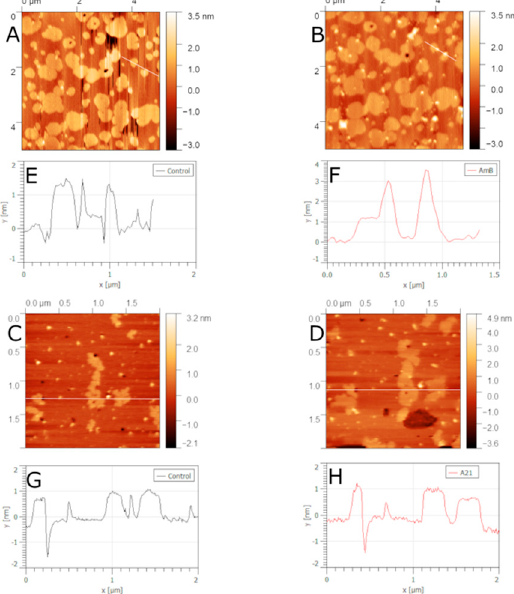
Figure 13. Topographic images of supported lipid bilayers composed of POPC:ESM 1:1 mol:mol + 20 mol% ergosterol in the presence ( B , D ) or absence of polyenes ( A – C ). Polyenes were added by increments of 0.5 µM until a clear effect was observed. For AmB ( B ), this occurred at 1 µM; for A21 at 2 µM. ( E – H ) show height profiles corresponding to the lines drawn on the topographic image.